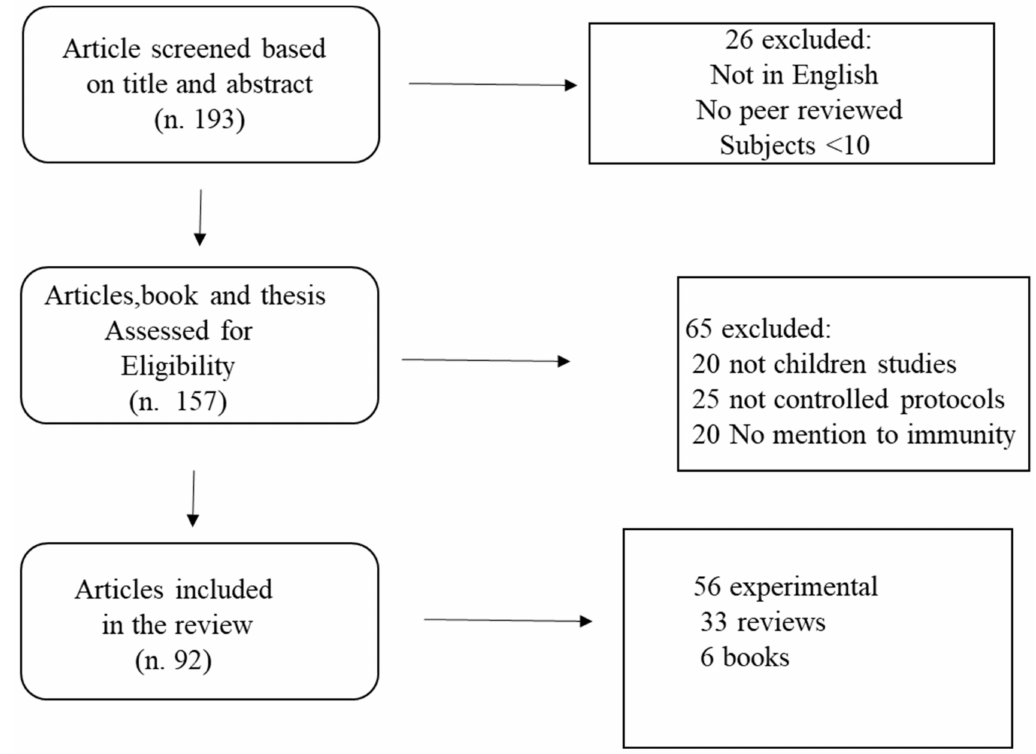
Figure 1. Flow chart of the search